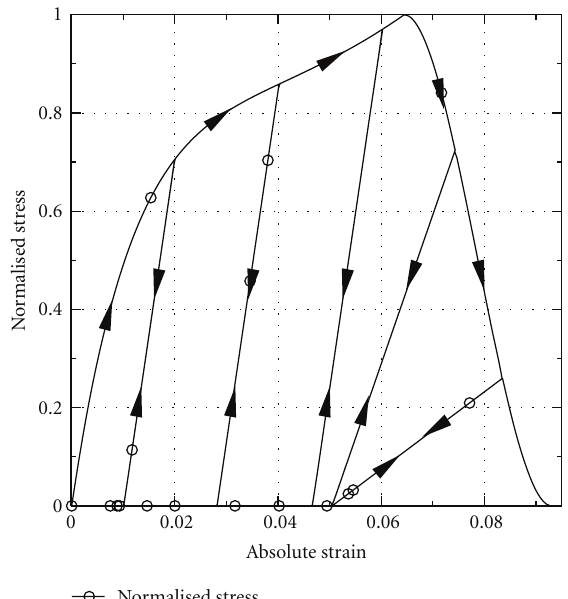
Figure 13: Element loaded-unloaded-reloaded in